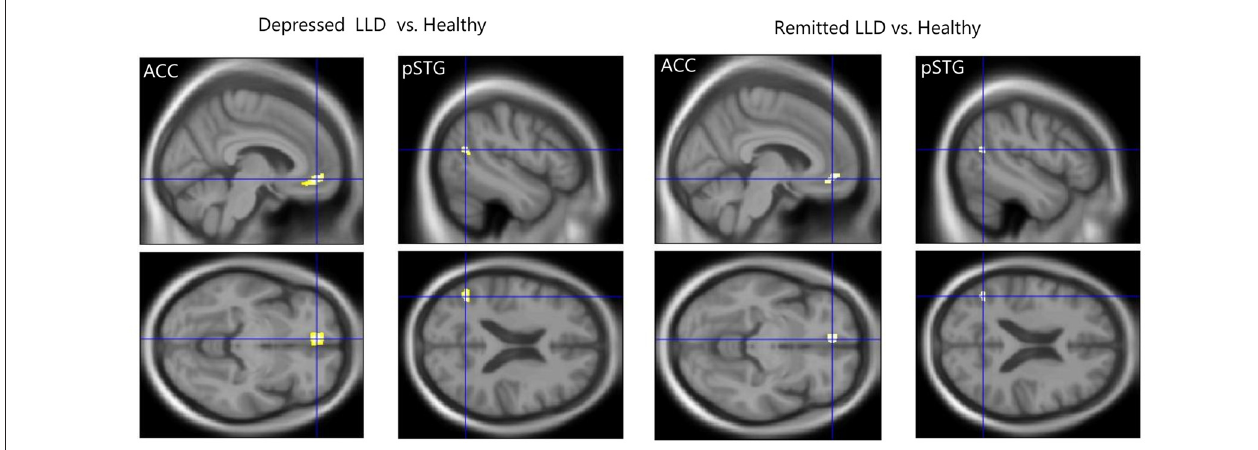
FIGURE 1 | Reduced gray matter (GM) volume in patients with later-life depression (LLD). Patients with acute LLD showed significantly smaller GM volumes in the left anterior cingulate cortex (ACC) and posterior superior temporal gyrus (pSTG) than did healthy subjects. Patients with LLD in remission showed significantly smaller GM volumes in the left ACC and pSTG than healthy participants. The cross-hairs mark the coordinates of the voxel of maximal statistical significance.